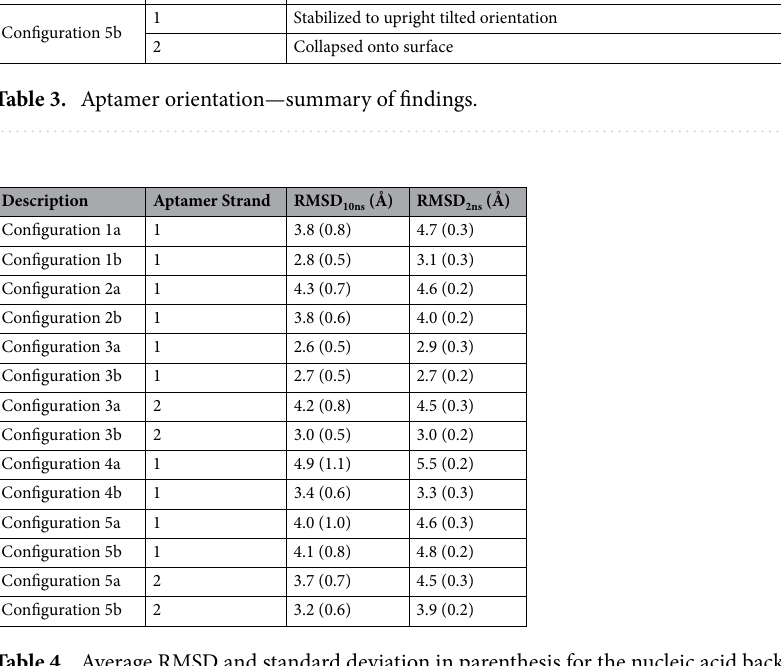
Table 4. Average RMSD and standard deviation in parenthesis for the nucleic acid backbone of the tethered aptamer in each configuration during the course of the 10 ns MD simulation and the final 2 ns of the MD